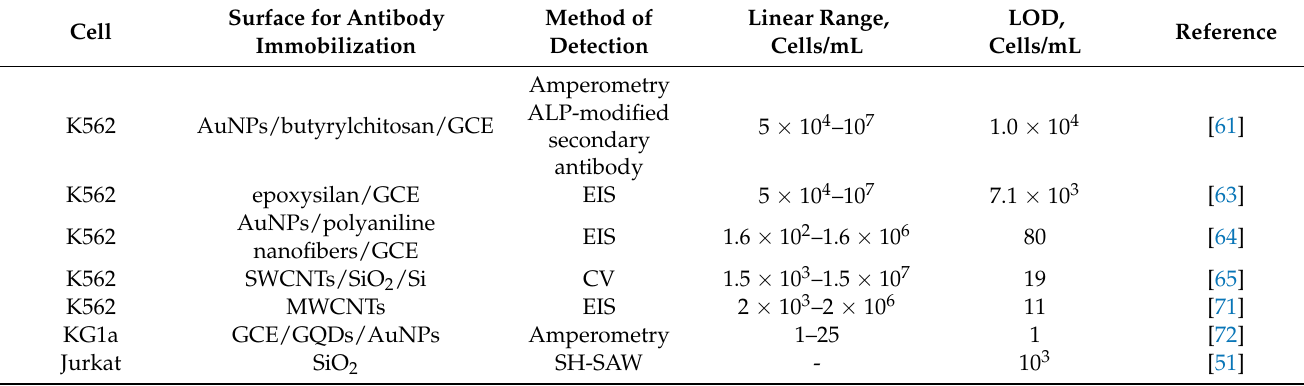
Table 1. The properies of the electrochemical and acoustic immunosensors for the detection of leukemic cells. Surface for Cell